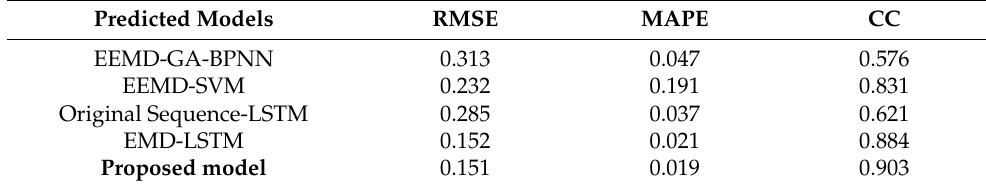
Figure 18. Comparison of prediction results of different prediction models. Table 5. Evaluation indicators of prediction results of different forecasting models.